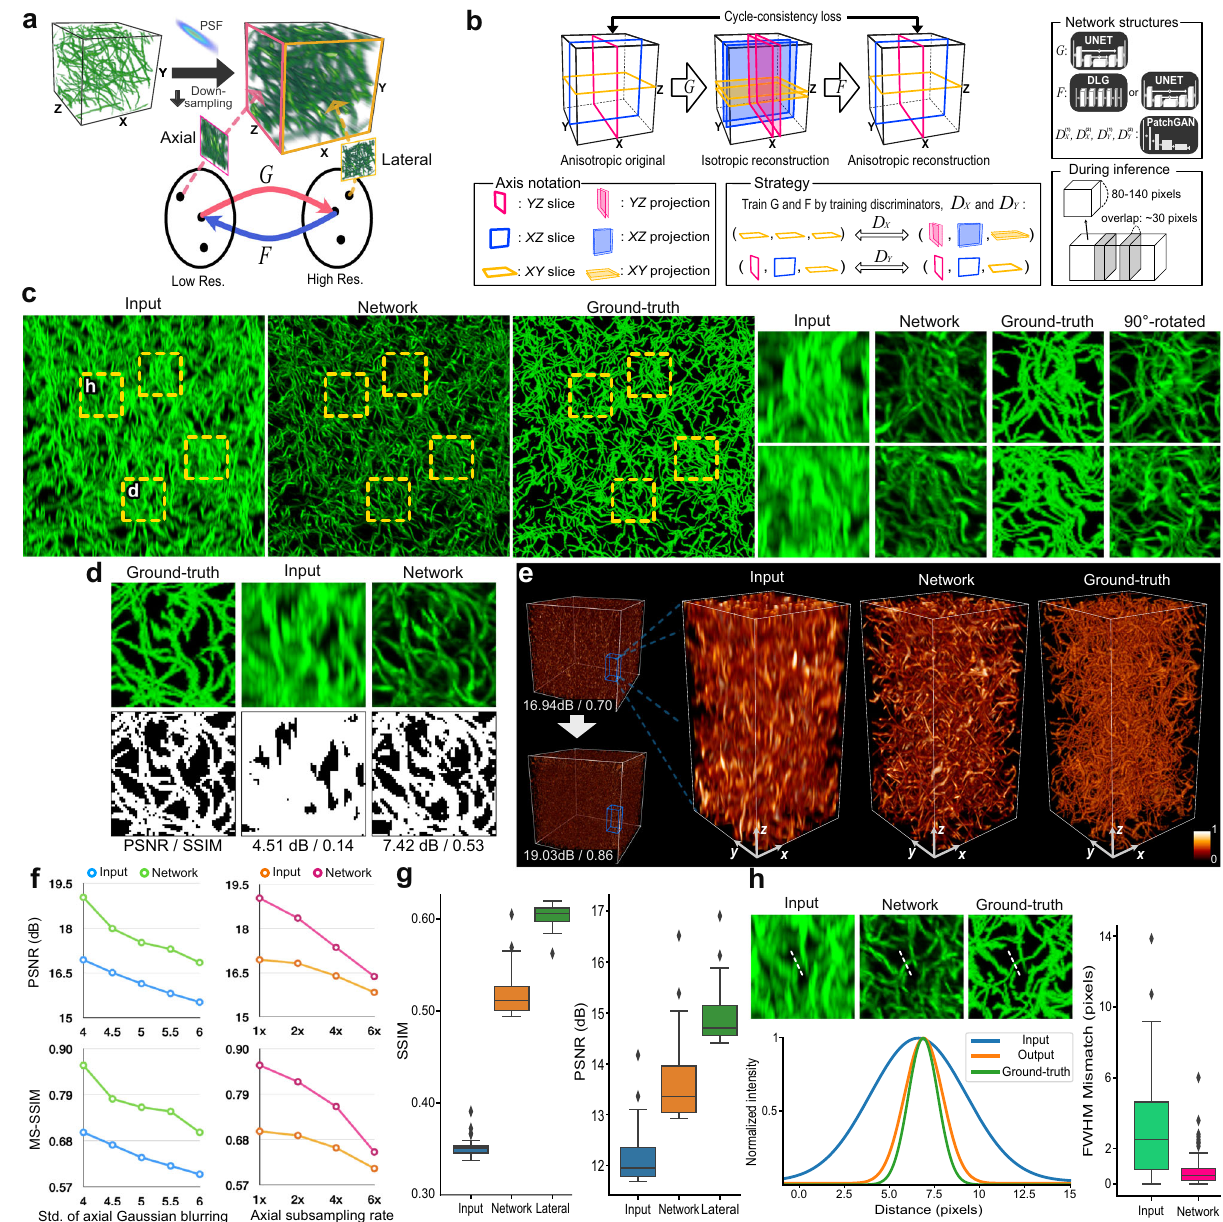
deconvolution. The synthetic volume, of 900 × 900 × 900 voxels, contains 10,000 tubular objects that were randomly placed and deformed by a 3D elastic grid-based deformation fi eld. This simulation model allows the tubes to intertwine with each other in a non-linear manner and is ideal for simulating biological samples with complex mesh tubular structures, such as micro- tubules or neuronal networks. The image was then convolved with a Gaussian kernel that blurs only axially with a standard deviation of 4. Supplementary Fig. 1 visualizes this generation process. The networks were trained using one image sample, and, during training and inference, we used mini-batches with sub- regions of 120 3 − 144 3 voxels. After inference, the sub-regions were stacked back to the original image space (Fig. 1b). Figure 1c – h shows the results of blind deconvolution by the proposed method. After the blind deconvolution, the network output resolved the intricate entangling of the tubes, which was previously masked by the axial blurring, as visually illustrated in